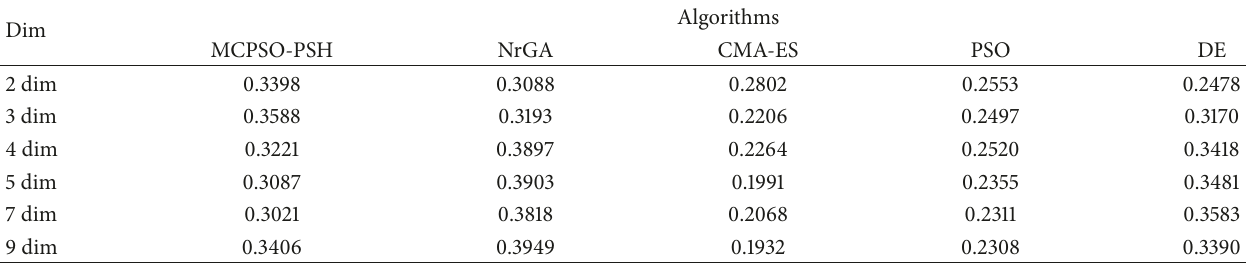
Table 6: The mean CPU time of the compared EA-based methods on Otsu